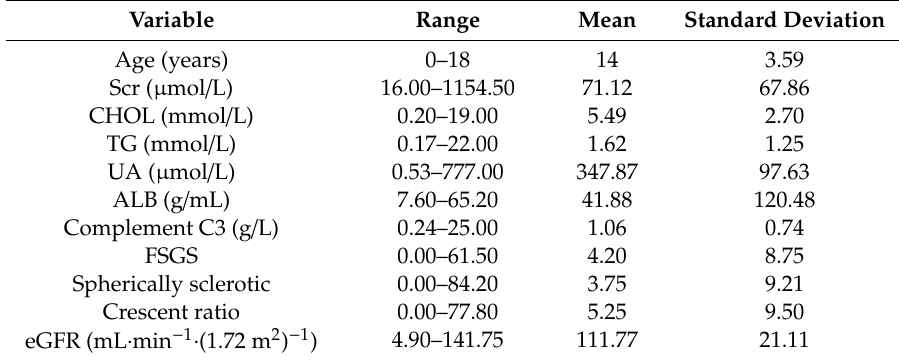
Table 1. Continuous independent variables.